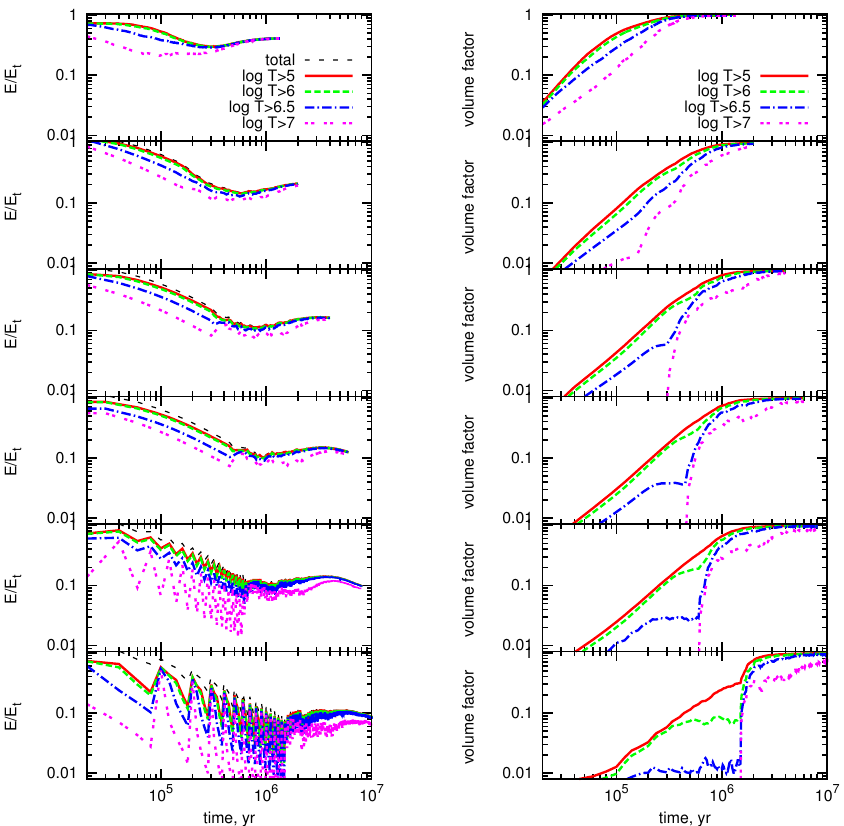
Figure 1. ( Left ) Evolution of the heating efficiency—a fraction of total energy injected by explosions retained in form of thermal energy in the phase with a given temperature (as indicated in the legend), top to bottom : SN rate 10 − 3 , 10 − 4 , 5 × 10 − 5 , ∼ 3 × 10 − 5 , 2.5 × 10 − 5 and 10 − 5 yr − 1 in the computational volume 200 3 pc 3 —the volume nearly equal to the CMZ. ( Right ) The volume filling factor of gas with given temperatures (see legend) for the same SN rates. From